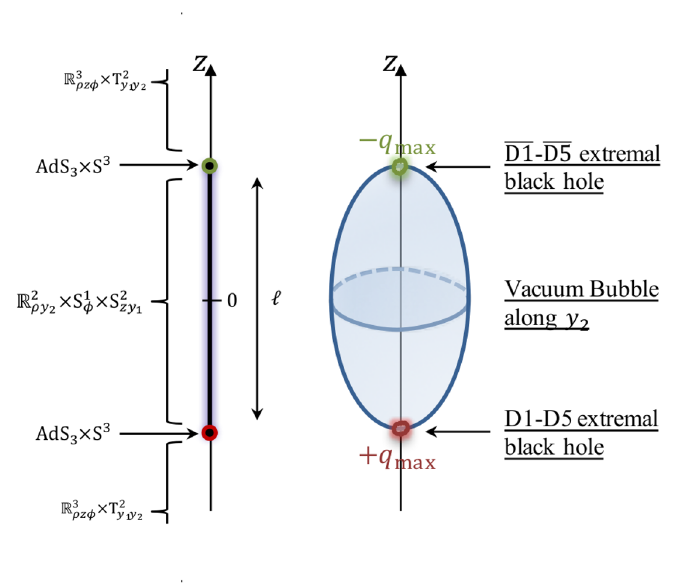
Figure 8 . Profile of the sources and topology on the z -axis for a bound state of BPS D1-D5 branes and anti-BPS D1-D5 anti-branes separated by a bolt corresponding to two extremal D1-D5 black holes of opposite charges hold apart by a vacuum